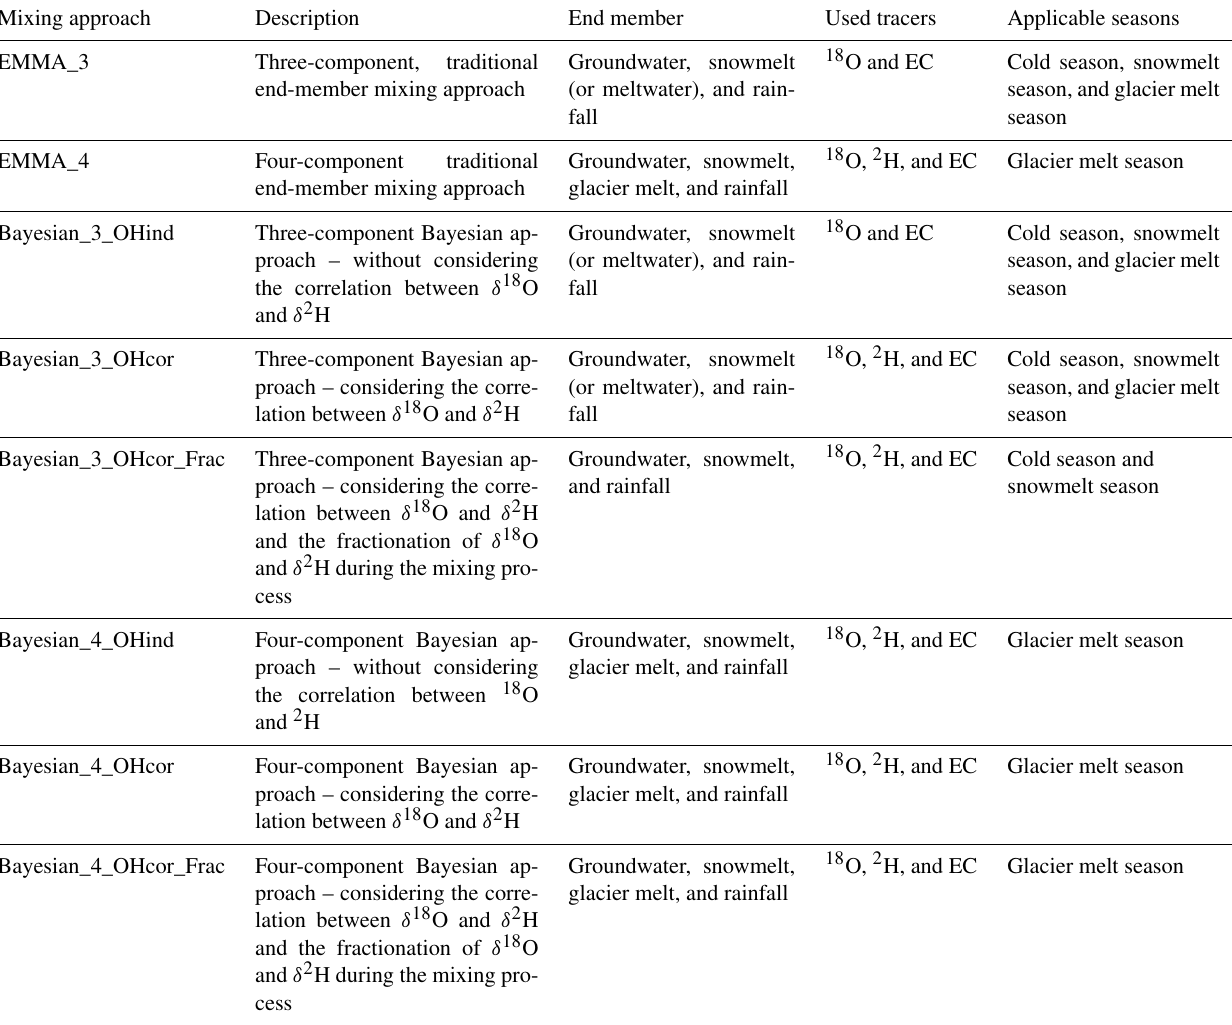
Table 2. Mixing approaches applied for hydrograph separation in different seasons. Mixing